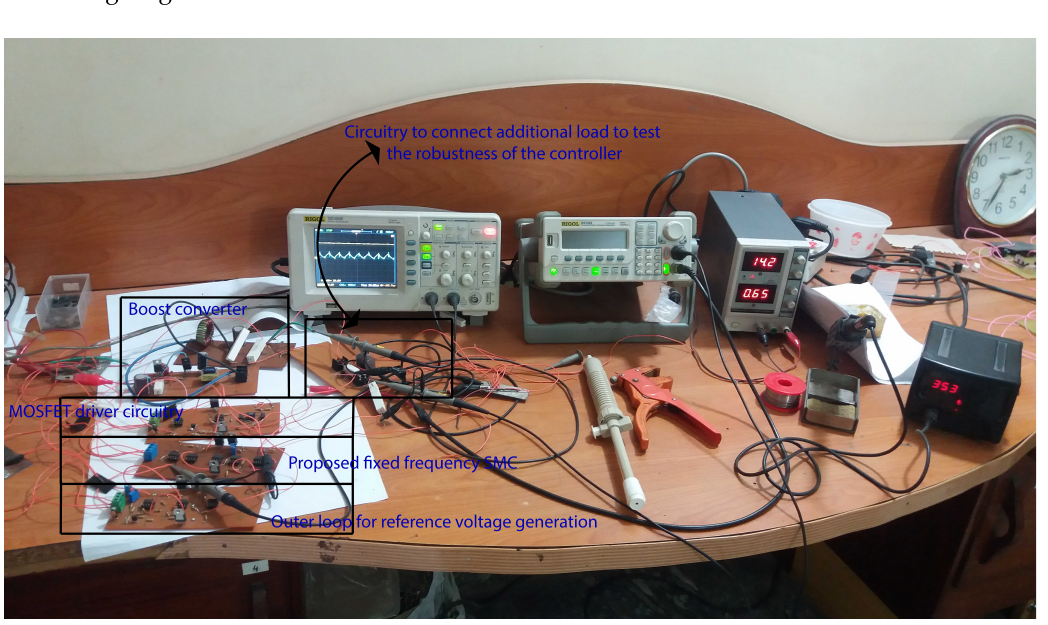
Figure 5. Experimental setup to evaluate the performance of the controllers. Table 1. Parameters of Buck